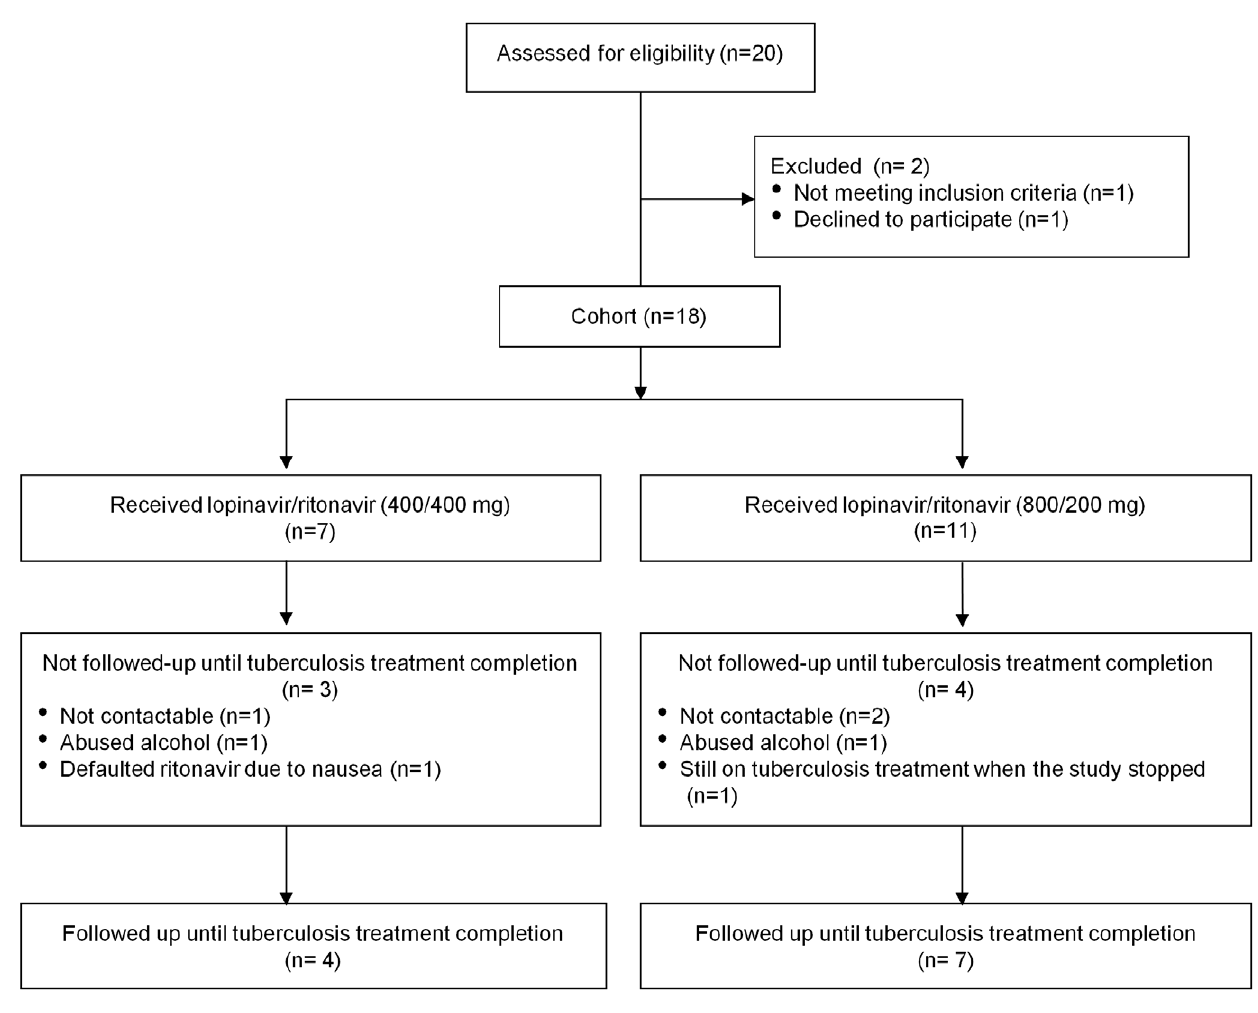
Figure 1. The profile of the study cohort.